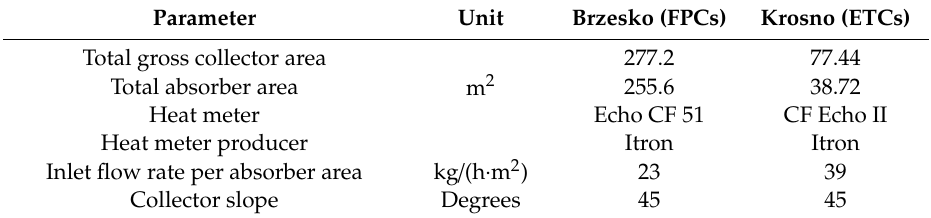
Figure 4. The scheme of the solar installation in Krosno (HM—heat meter ( TH 1 and TH 2 temperature and volumetric flow meter included); 3V-1—three-way valve switching storage tank charging; 3V-2—three-way bypass valve; HWT-1, HWT-2—solar hot water tank). Table 2. Characteristics of solar installations. Source: own study based on References [44,45]. Parameter Unit Brzesko (FPCs) Krosno (ETCs)